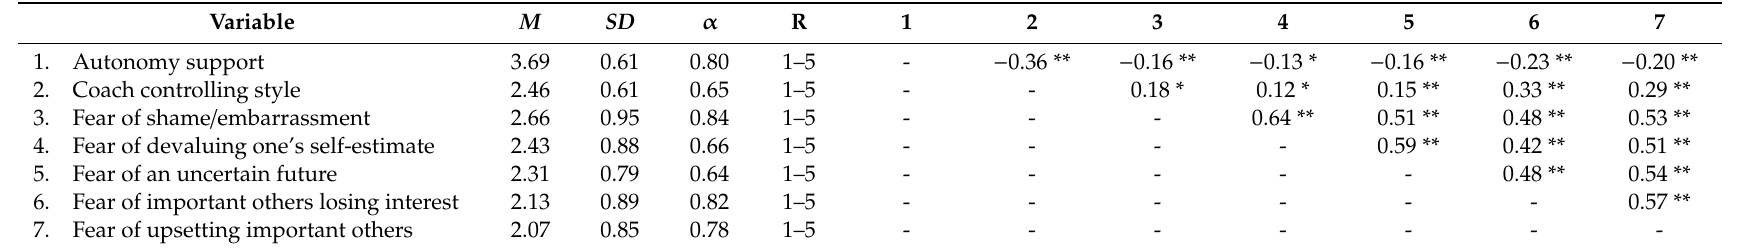
Table 1. Means, standard deviations and correlations among the variables.